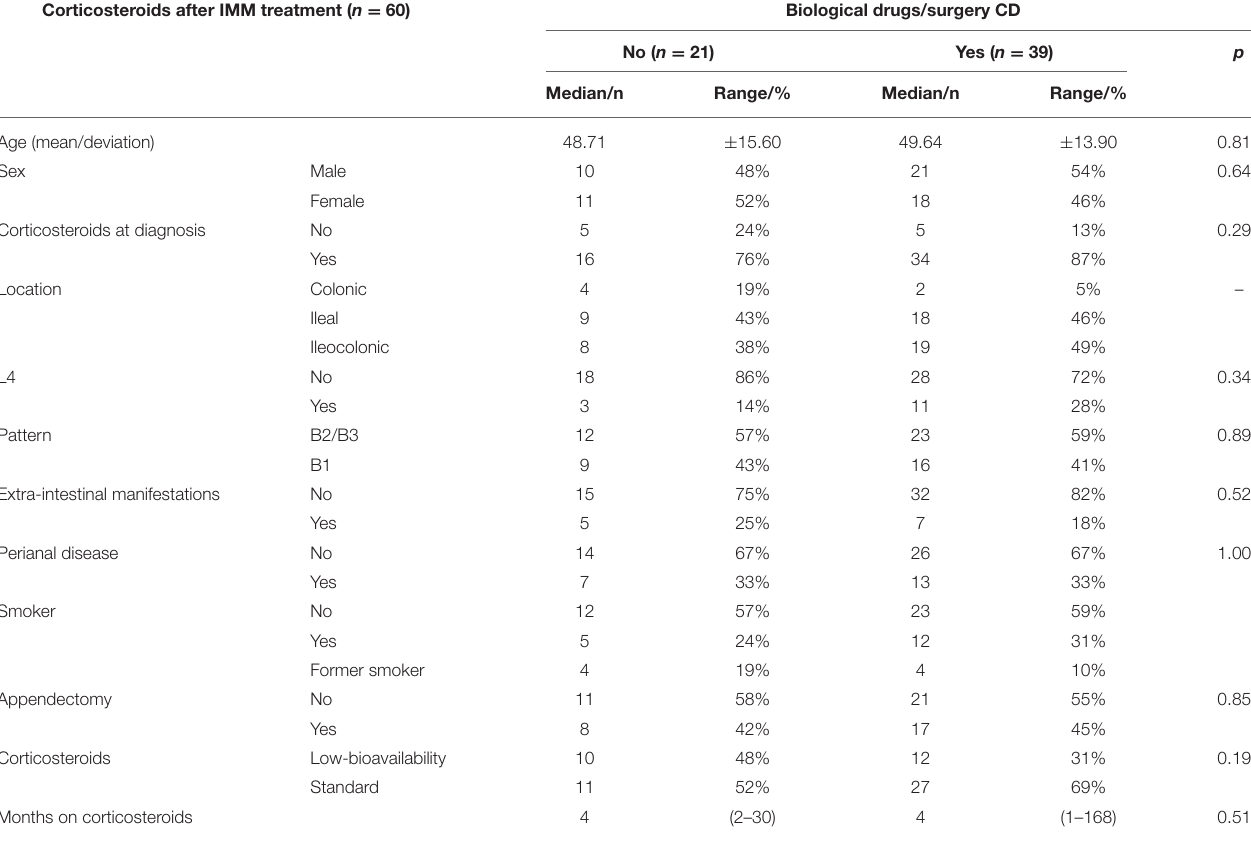
The bold values highlight the variables which are statistically significative. TABLE 5 | Requirement for rescue therapy with biological drugs/surgery in immunosuppressed patients with CD who have needed treatment with corticosteroids. Corticosteroids after IMM treatment ( n =